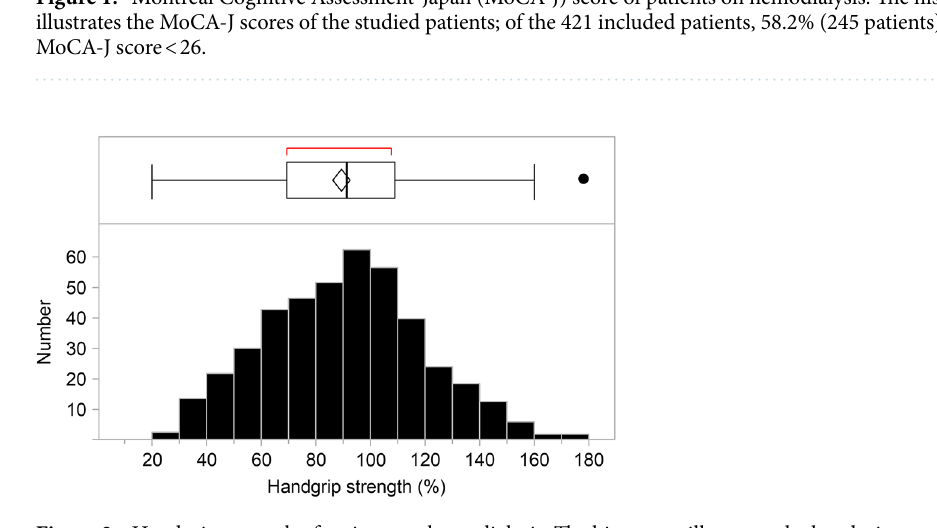
Figure 2. Handgrip strength of patients on hemodialysis. The histogram illustrates the handgrip strength of the studied patients. We defined 100% handgrip strength as 28 kg in males and 18 kg in females, according to